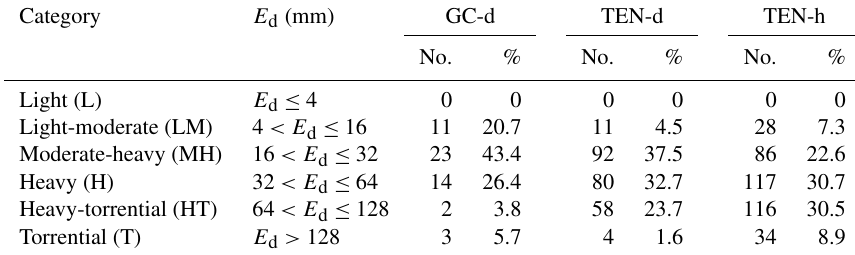
Table 2. Summary of the number (no.) and percentage (%) of MPRC in the categories proposed by Alpert et al. (2002) at the two test sites. Category E d (mm) GC-d TEN-d TEN-h No. %